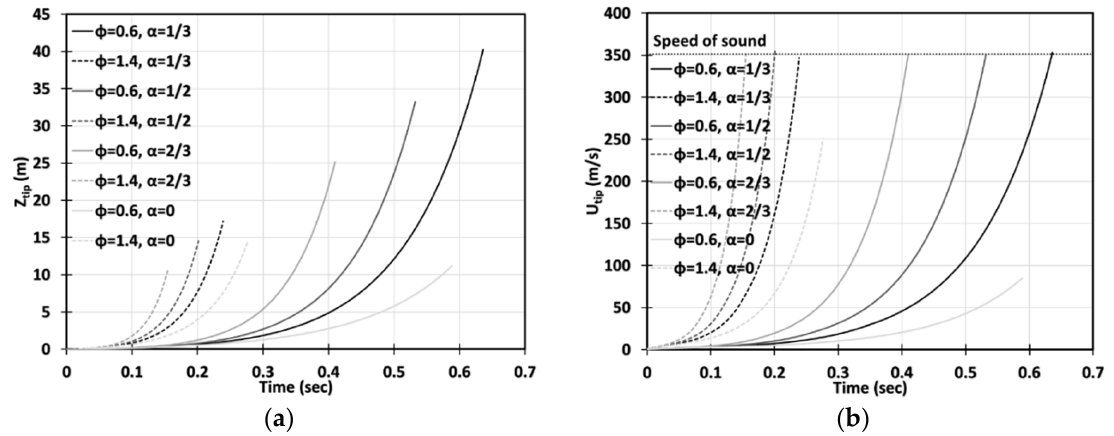
Figure 9. Time evolution of the flame tip position (cid:1852) (cid:3047)(cid:3036)(cid:3043) ( a ) and velocity (cid:1847) (cid:3047)(cid:3036)(cid:3043) ( b ) in a cylindrical- Figure 9. Timeevolutionoftheflametipposition Z tip ( a )andvelocity U tip ( b )inacylindrical-axisymmetric axisymmetric geometry for highly-lean ( (cid:2038) = 0.6 ) and highly-rich ( (cid:2038) = 1.4 ) CH 4 -air burning with geometry for highly-lean ( φ = 0.6) and highly-rich ( φ = 1.4) CH 4 -air burning with various blockage various blockage ratios (cid:2009) = 0, 1 3,⁄ 1 2,⁄ 2 3⁄ . ratios α =